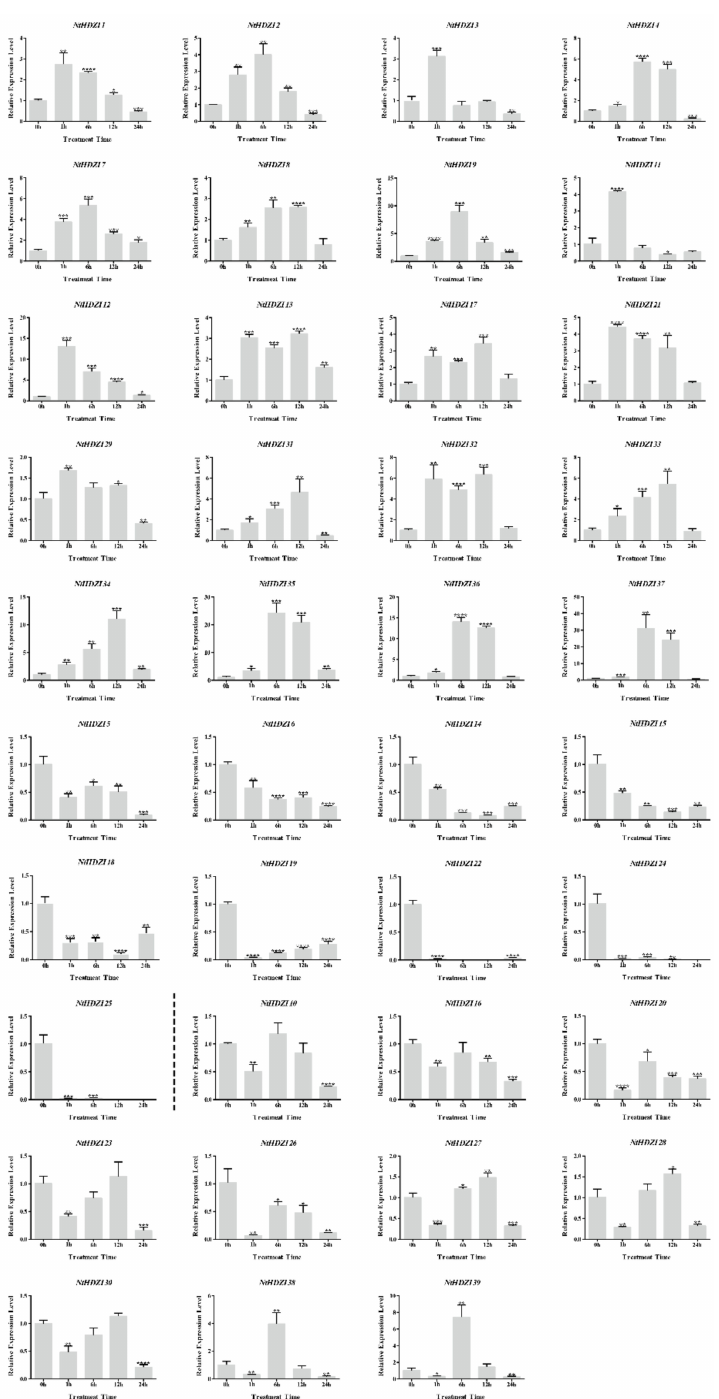
Figure 7. The expression levels of 39 NtHD-Zip I genes in N. tabacum under ABA (200 µ M) treatment. Bars represent the mean values of three replicates ± standard deviation (SD). All of the expression levels of the NtHDZI genes were normalized by the expression levels of NtEF1 α . Untreated leaves (0 h) were normalized as “1” at each graph.****, ***, **, and * indicate significant di ff erence compared to the control (0 h) at p < 0.0001, p < 0.001, p < 0.01, and p < 0.05,